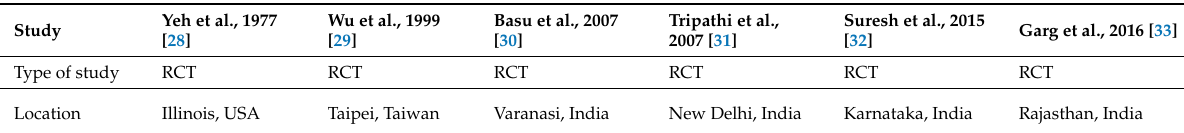
Table 1. Characteristics of included